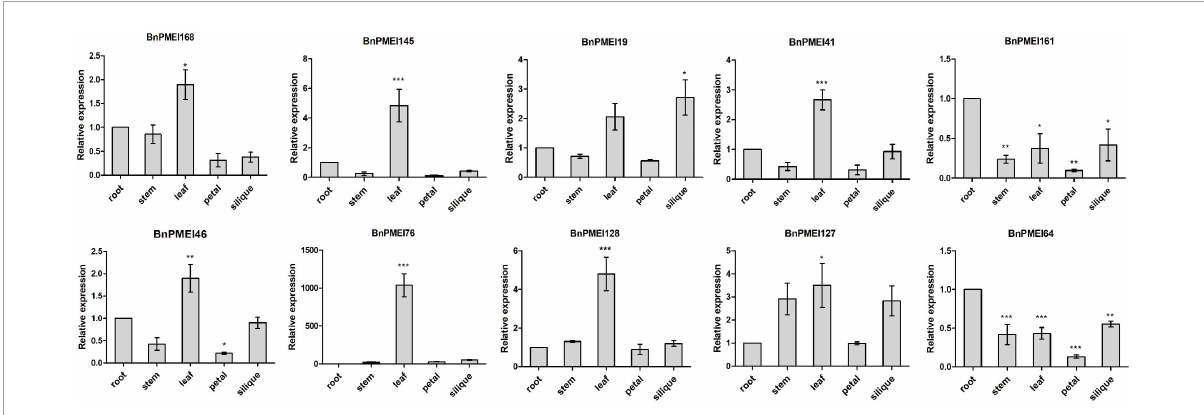
FIGURE7 Expression profiles of the selected ten BnPMEIs in five different tissues including root, stem, leaf, petal, and silique at full-bloom stage of B. napus . The relative expression levels were analyzed by qRT-PCR and expressed as a ratio relative to that of root. Error bars are mean ± SEM, n = 3. Significant differences between different tissues and root are denoted as follows: *** P < 0.001; ** P < 0.01; * P < 0.05.